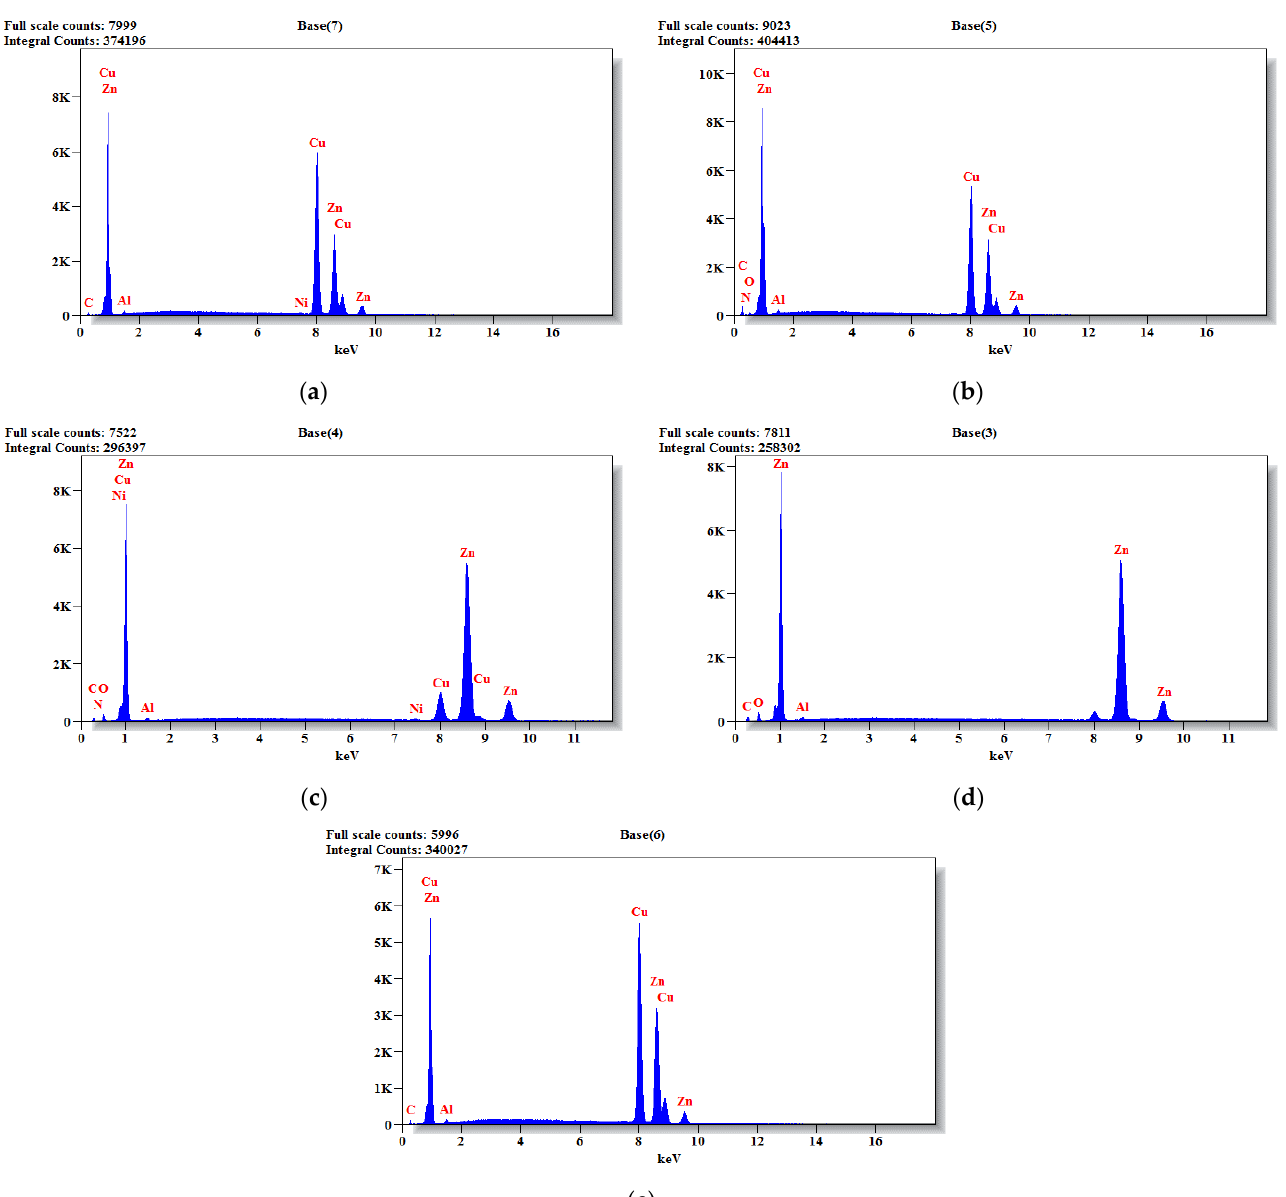
Figure 20. SEM Images of raw carbon fibre subjected to different temperatures. ( a ) Room tempera- ture; ( b ) 200 °C; ( c ) 400 °C; ( d ) 600 °C; ( e ) 800 °C.